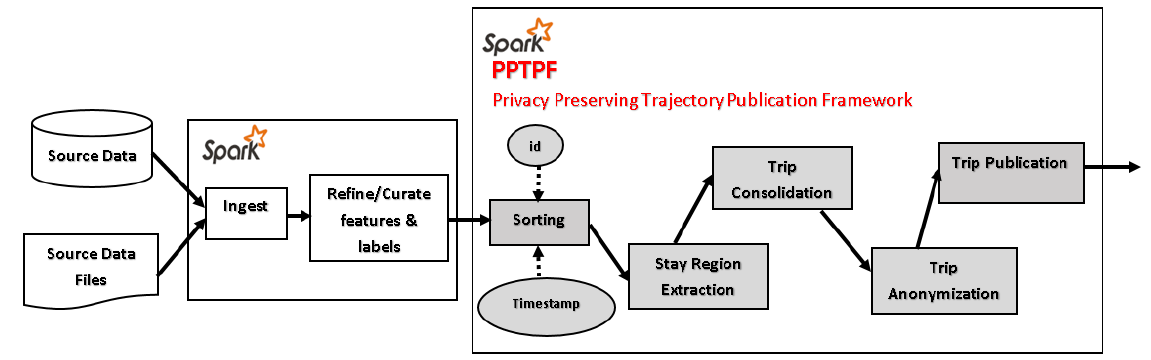
Figure 2. Privacy-preserving trajectory publishing